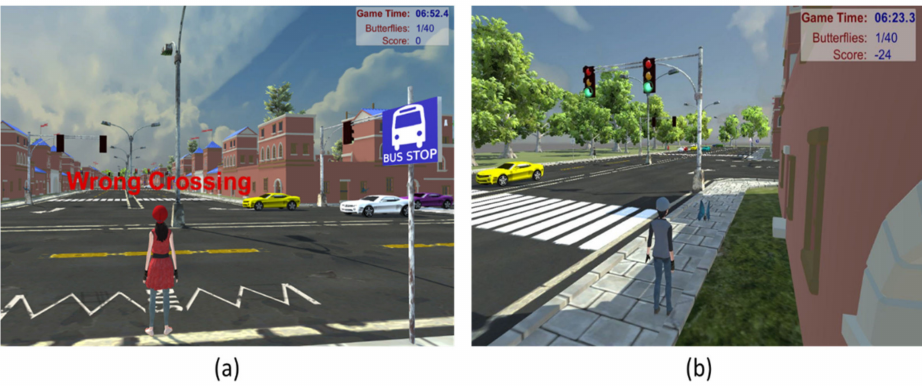
Figure 9. Children performance evaluating system where ( a ) shows the warning UI system and ( b ) represents the scoring